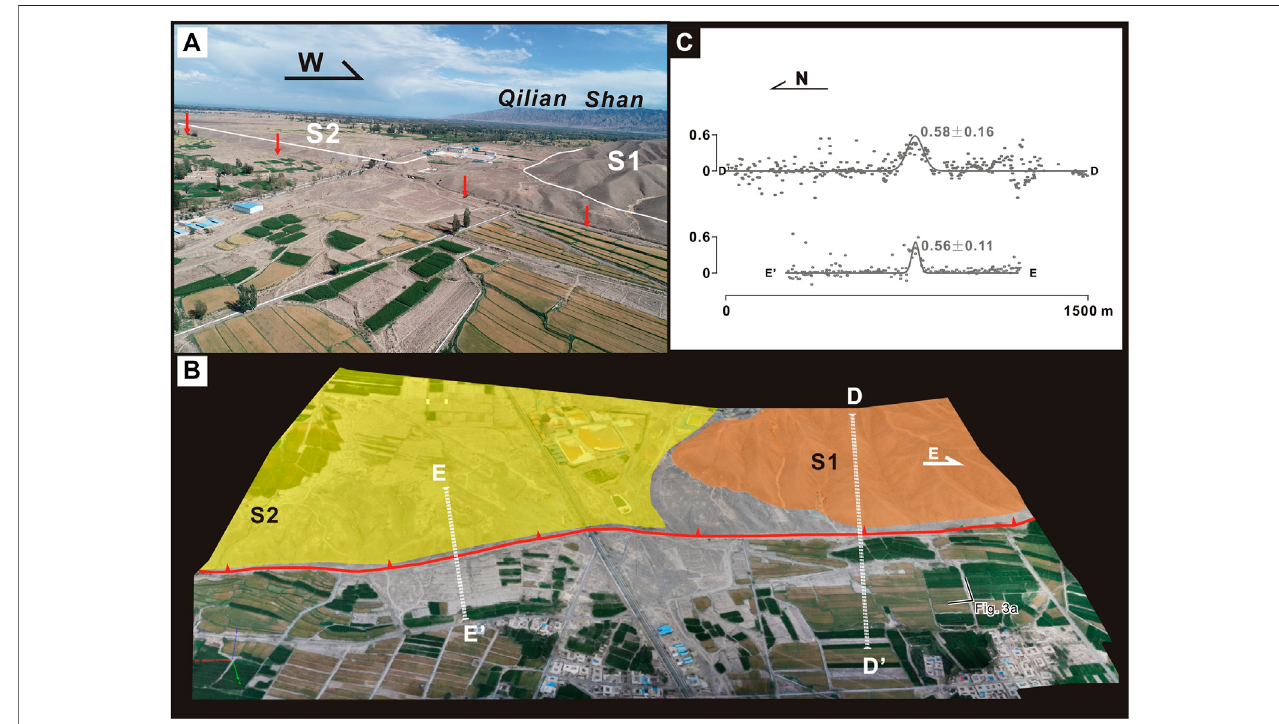
FIGURE 3 | (A) Aerial photography of the Kangningqing site. The red line shows the fault track. (B) 3D topography of the surveyed site. The measuring lines are normal to the fault strike. (C) Using the high resolution DEMs generated by drone scanning stereopair, we extract the slope pro fi le of the fault scarp and obtain the maximum